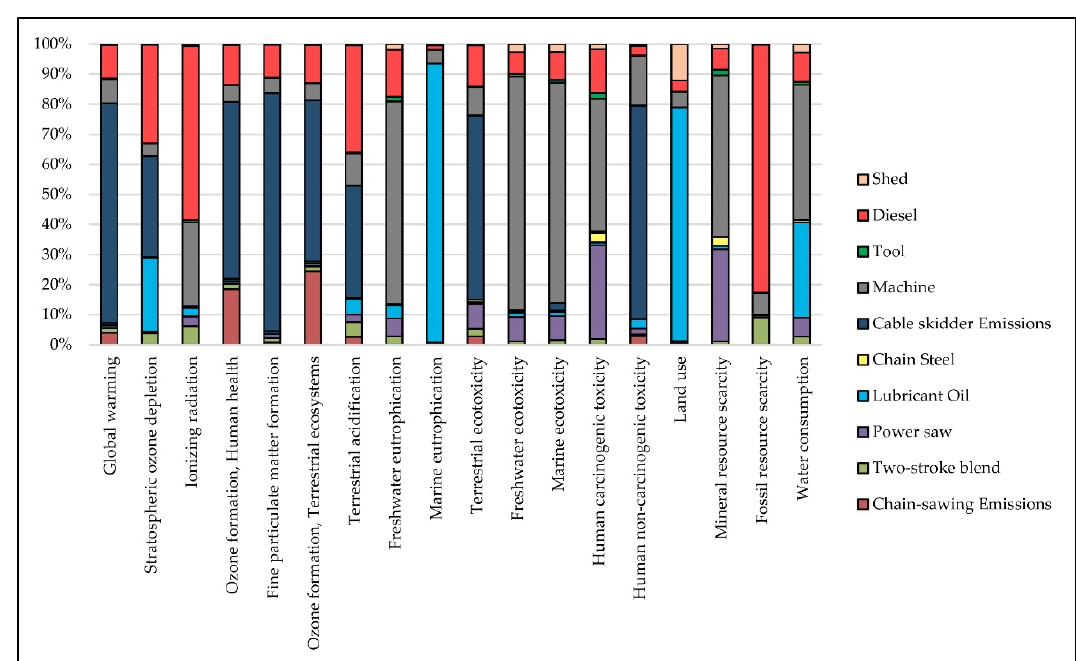
Figure 8. Contribution analysis related to scenario (i), cable skidder.